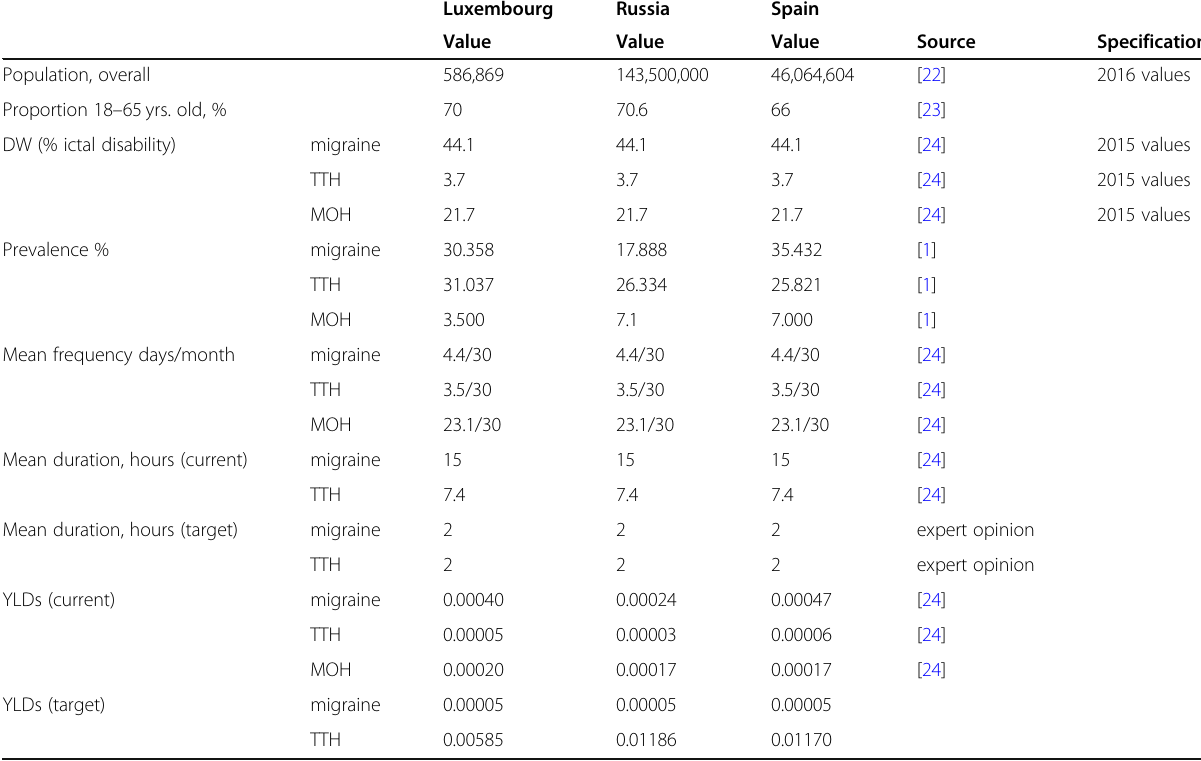
Table 4 Epidemiological data, disability weights, prevalence, frequency and duration of